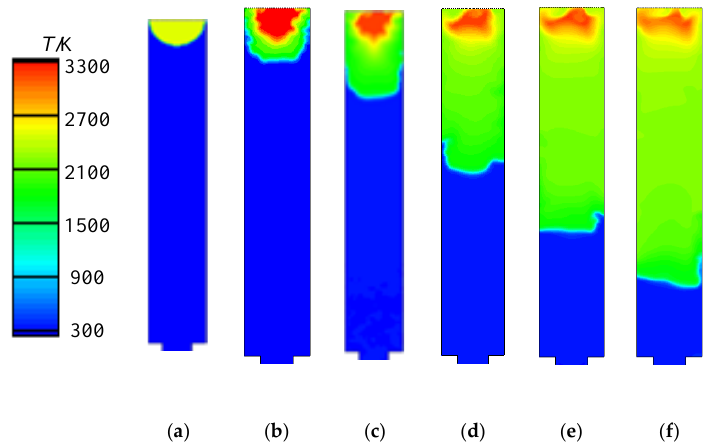
Figure 5. Hot jet formation process ( a ) t HJ = 0 ms, ( b ) t HJ = 0.15 ms, ( c ) t HJ = 0.3 ms, ( d ) t HJ = 0.6 ms, ( e ) t HJ = 0.9 ms, ( f ) t HJ = 1.2 ms.